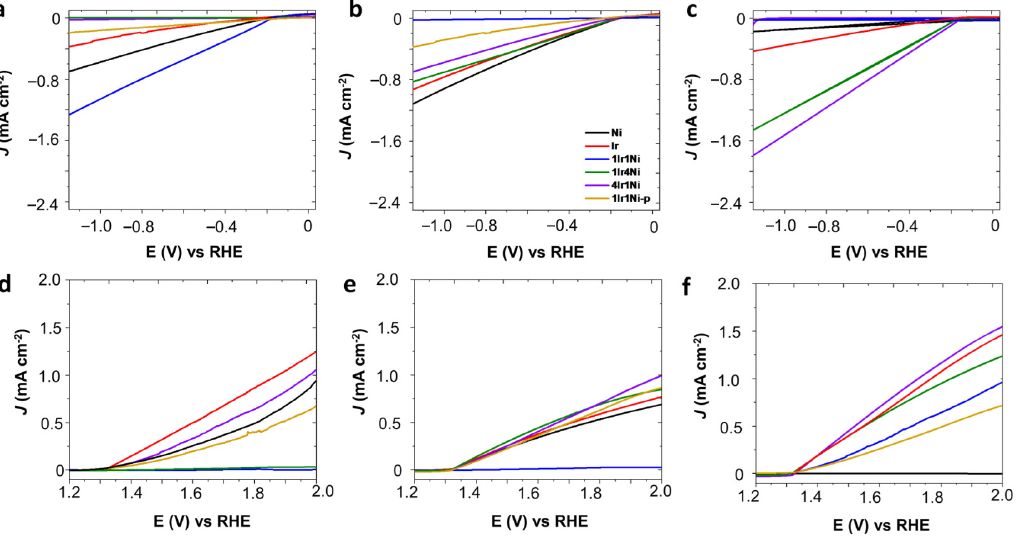
Figure 2. Linear sweep voltammetry (LSV) curves of Ir and Ni metal and alloys on activated carbon matrix, test performed at 50 mV s − 1 scan rate in the dark (light off) condition in ( a , d ) 0.1 M NaOH, ( b , e ) 0.1 M Na 2 SO 4 and ( c , f ) 0.1 M H 2 SO 4 electrolyte at room temperature. Material code is similar in all graphs and refers to ( b ) for the labeling (blue: 1Ir1Ni@AC, violet: 4Ir1Ni@AC, red: Ir@AC,